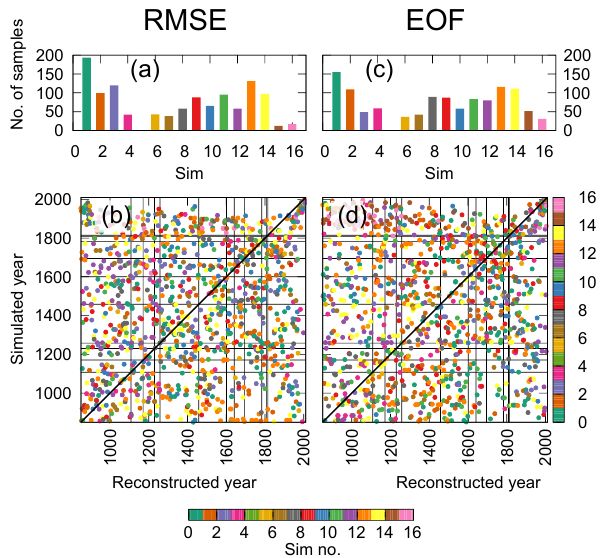
Figure 4. Selection of analogues used to carry out a perfect PPE. Bars in panels (a, c) indicate the number of times the analogue has been taken from each of the 16 models. The points in panels (b, d) indicate the relationship between the reconstructed year ( x axis) and the model (colour) and simulated year ( y axis) used as analogue for the reconstruction. Black horizontal and vertical lines show the timing of major volcanic eruptions according to Sigl et al. (2015). Panels (a, b) correspond to the reconstruction based on RMSE and (c, d) based on Euclidian distance in the EOF